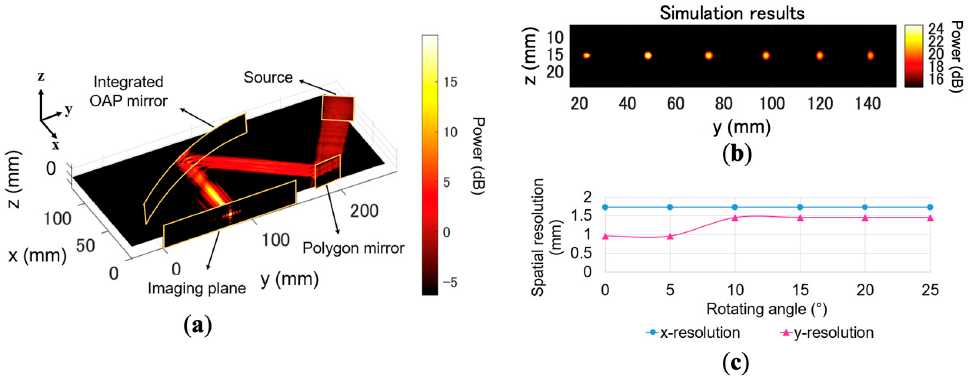
Figure 8. ( a ) Simulation results of the integrated OAP mirror beam path with the proposed setup. ( b ) Simulation results of the imaging plane at different incident angles. ( c ) Simulation results of the spatial resolution of both axes. The blue dots represent the resolution in the y-direction, and the pink triangles indicate the resolution in the z-direction.